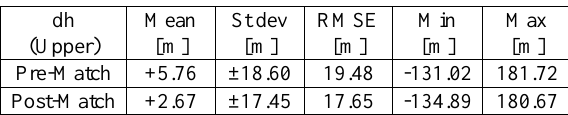
Table 4. Statistics of elevation differences over stable terrain